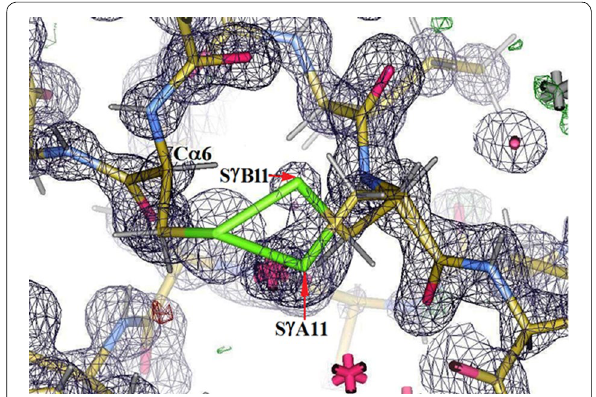
Fig. 13 Electron density in the disordered internal S–S bridge in Insugen (I) chain C between Sγ6–Sγ11. Atom Sγ11 occupies two clear sites A (80%) and B (20%). Sγ6 occupies a single site. Drawn with WinCoot 0.3